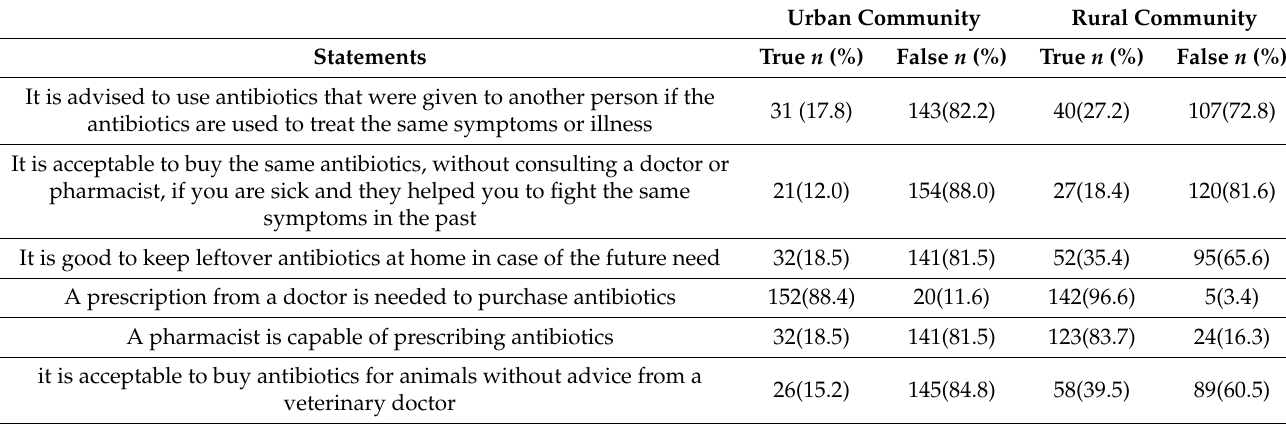
Table 5. Respondents’ perception regarding antibiotic usage.